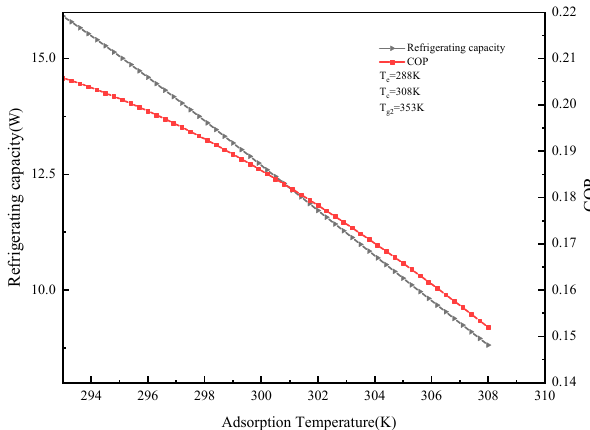
ff ect of adsorption temperature on refrigeration capacity and Figure 8. Effect of adsorption temperature on refrigeration capacity and COP. Figure 8. E Figure 8. Effect of adsorption temperature on refrigeration capacity and COP.